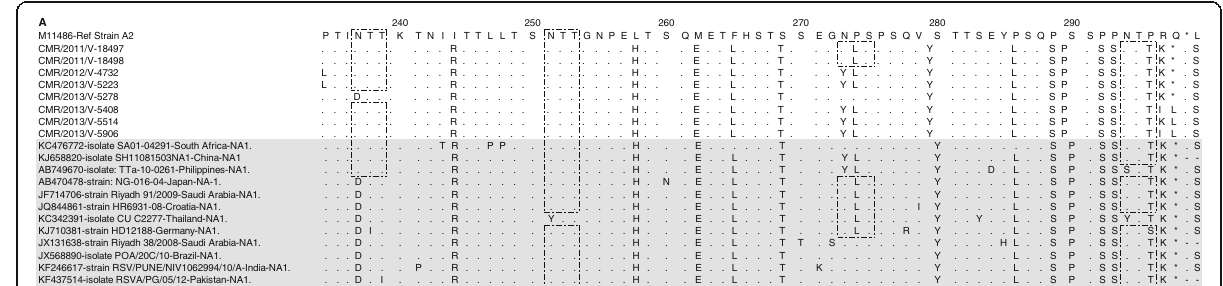
Fig. 3 Alignment of deduced amino acid of the second hypervariable region of the G gene from the sequences of HRSV-A. The alignments are presented in reference to strain A2 (M11486, positions 234 – 300). Identical residues are represented by dots and stop codons by asterisks. The lack of amino acid is represented by dashes. The light gray shading delineates the borders of Cameroonian sequences. Potential N -glycosylation sites (NXT/S, where X is not proline) are shown by light dashed rectangles. Reference sequences are identified from left to right by GenBank accession number, the name of the strain, country, and genotype. Cameroonian sequences are named from left to right by CMR (Cameroon), year of